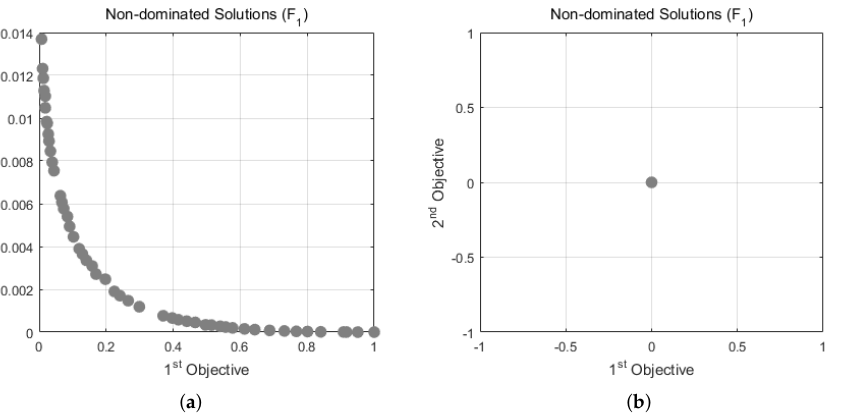
Figure 2. Example of a two-objective minimization problem solution set. ( a ) Mutually constrained dual-target Pareto front. ( b ) Unconstrained two-objective optimization